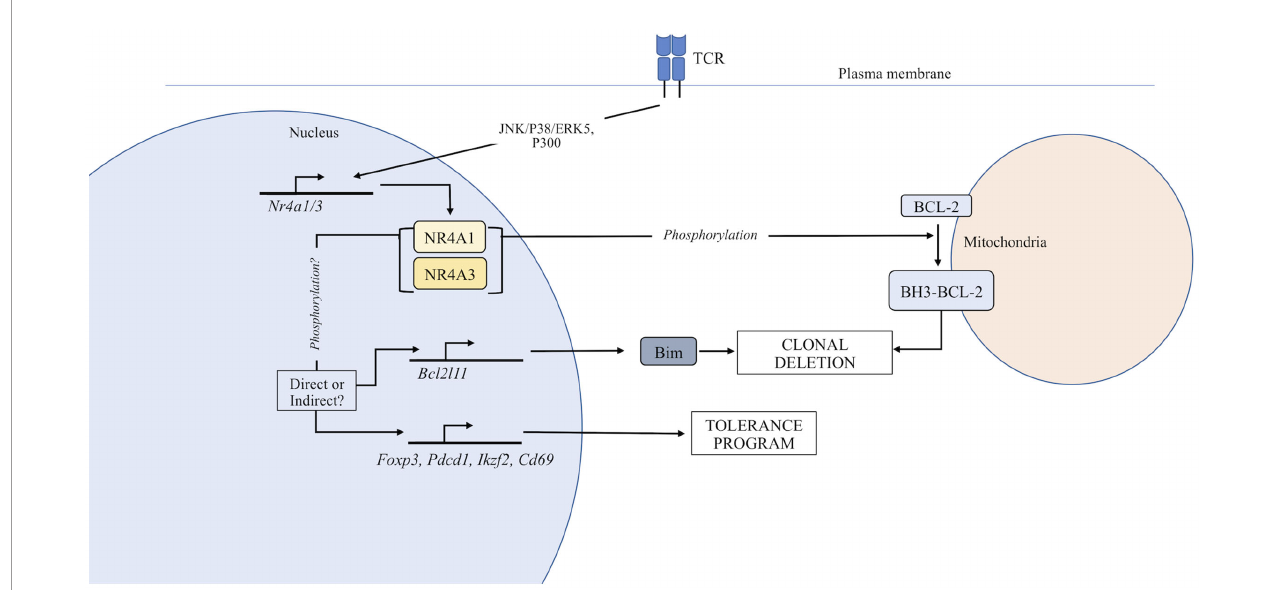
FIGURE 1 | Function of the NR4A family in thymocyte development. TCR stimulation induces expression of the NR4A family. In the nucleus, NR4As can regulate the expression of genes that control T cell tolerance. Additionally, NR4A family members can be exported from the nucleus where they directly regulate apoptosis through an interaction with